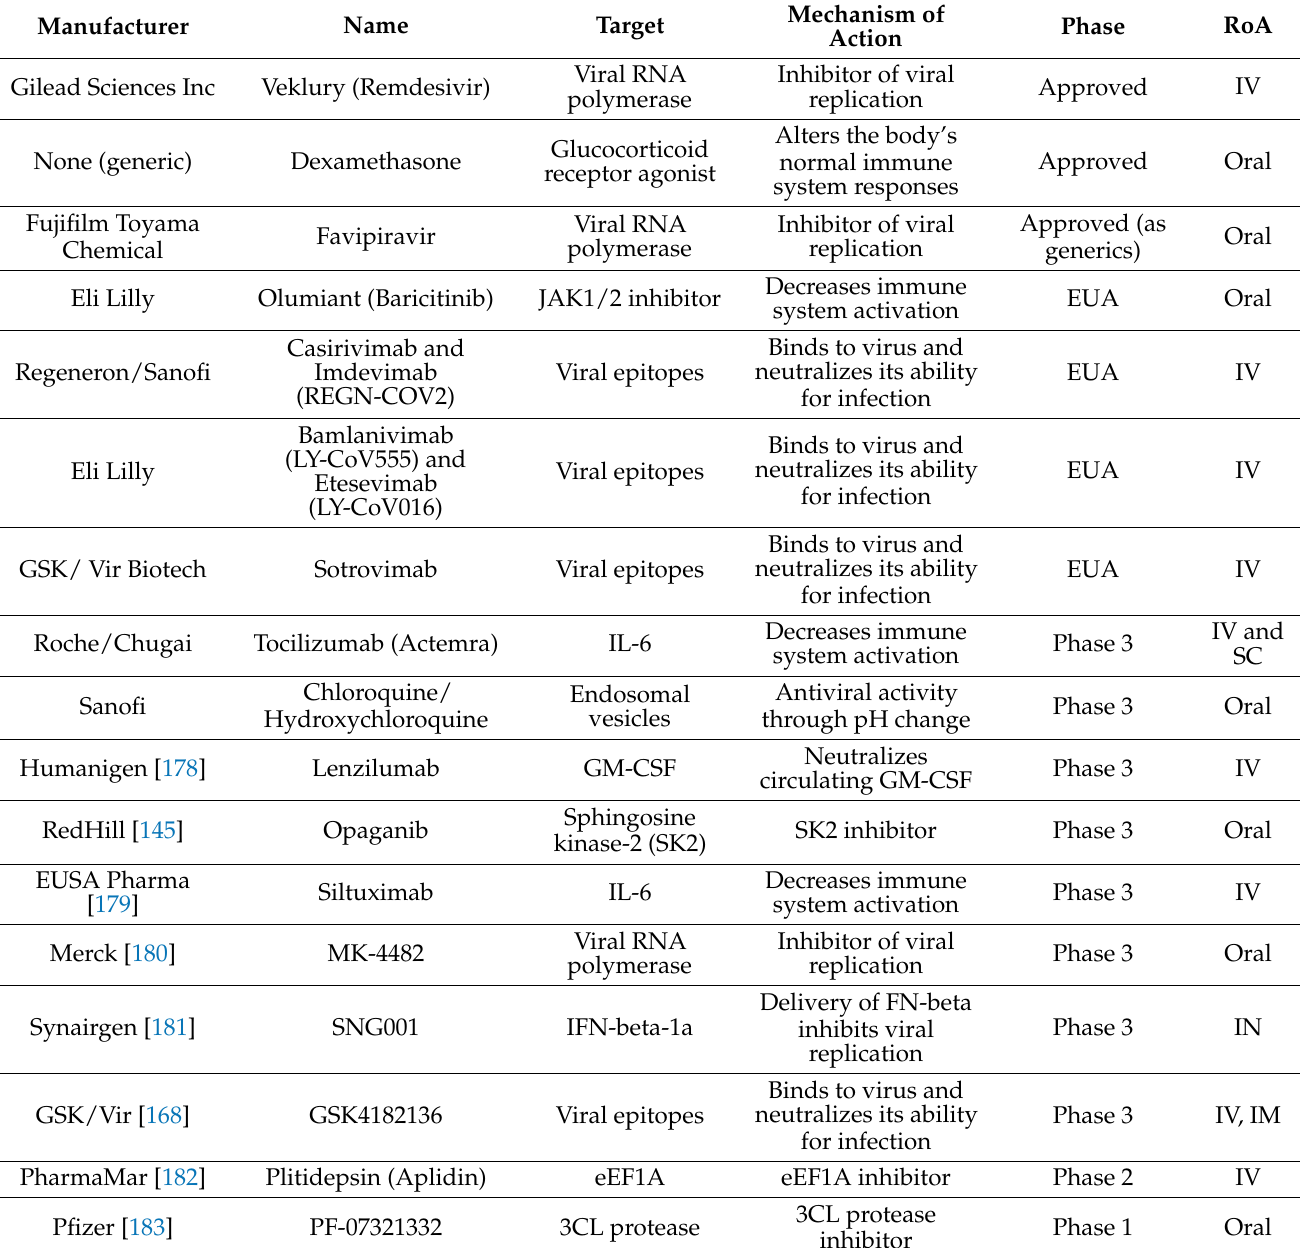
Table 5. Promising COVID-19 therapeutic drugs in clinical